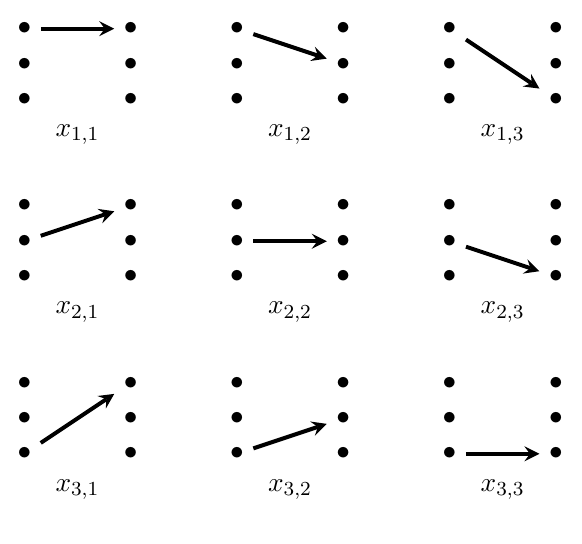
Figure 3 . Elements of S 3